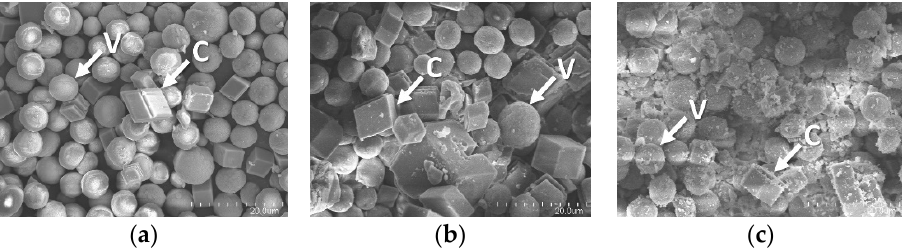
Figure 10. SEM images of the precipitated CaCO 3 . ( a ) Reaction catalyzed by R5-SazCA; ( b ) reaction